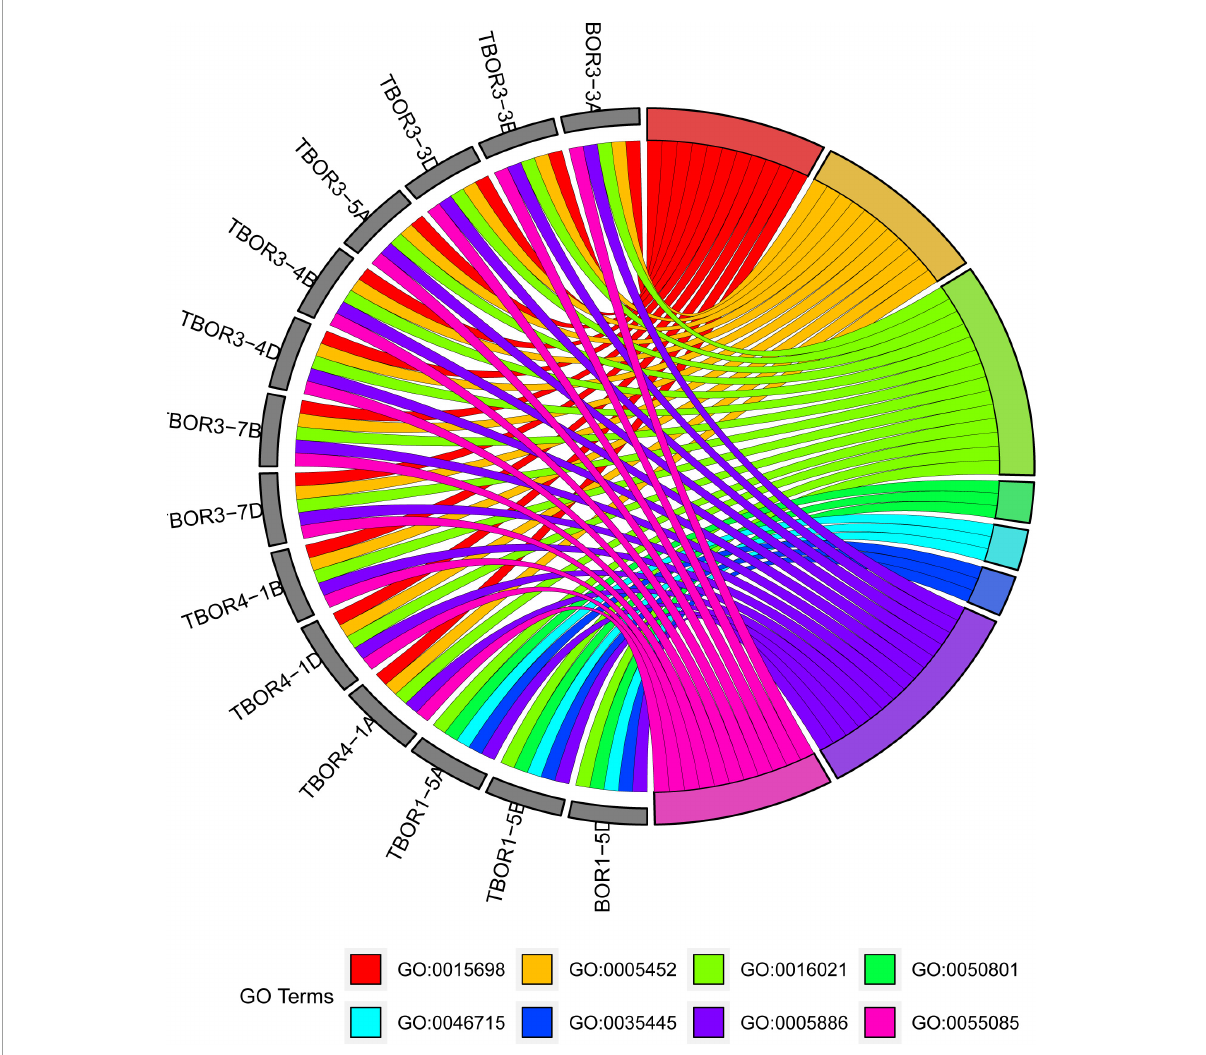
FIGURE6 GO enrichment results. GO0015698: inorganic anion transport, GO0005452: inorganic anion exchanger activity, GO0016021: integral component of membrane, GO0050801: ion homeostasis, GO0046715: active borate transmembrane transporter activity, GO0035445: borate transmembrane transport, GO0005886: plasma membrane, GO0055085: transmembrane